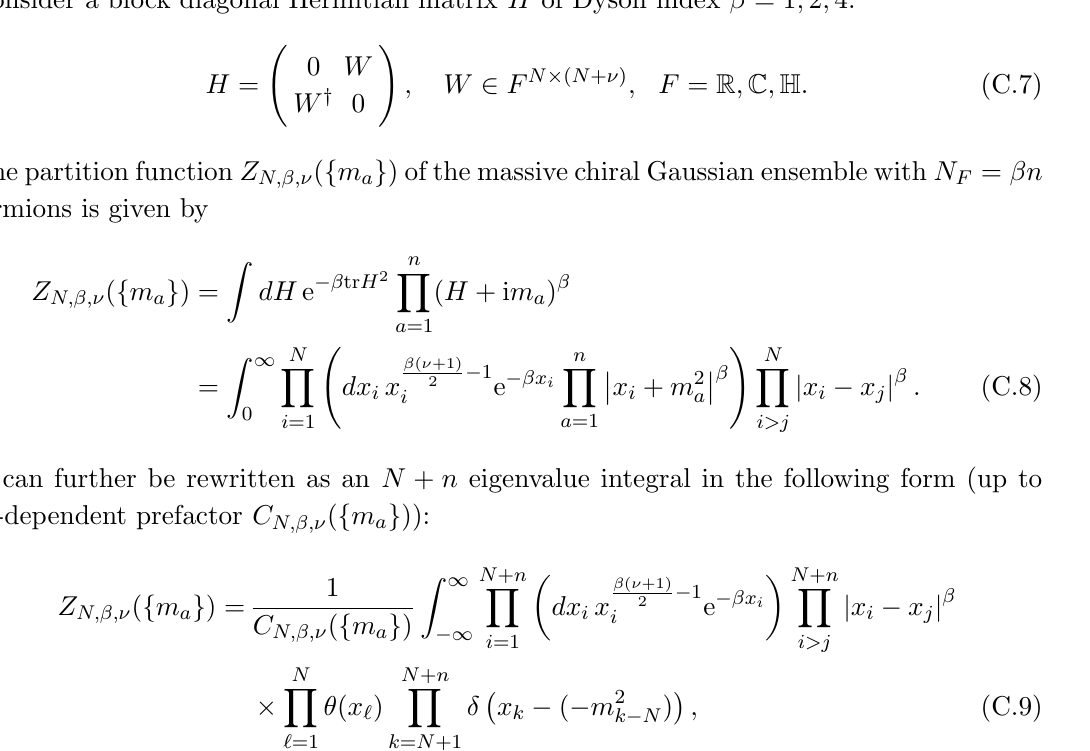
( f(cid:0) m 2 g ). (B) For m 2 > k;n; [0 ;s ] a a